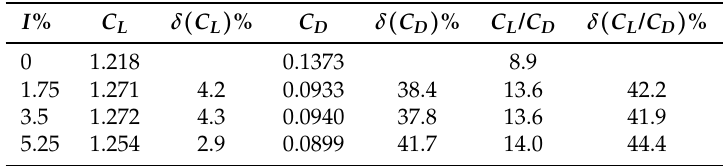
Table 7. Sensitivity study on the inflow turbulence intensity I for Re = 10 4 and AoA = 8 ◦ . δ is the relative difference with the turbulence intensity I = 0%